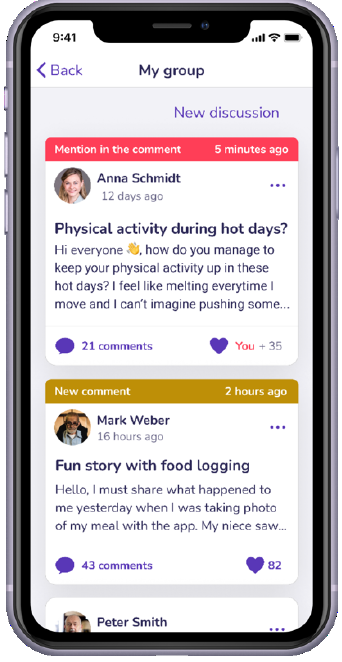
Figure A3. Tracking of weight change.